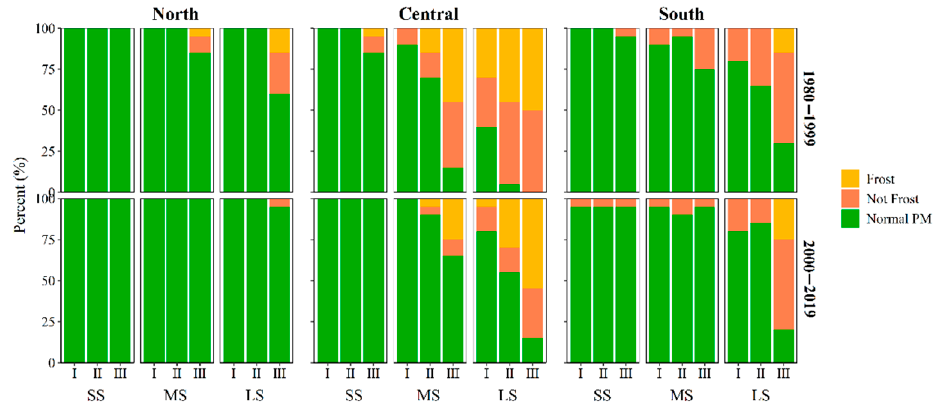
probability level.